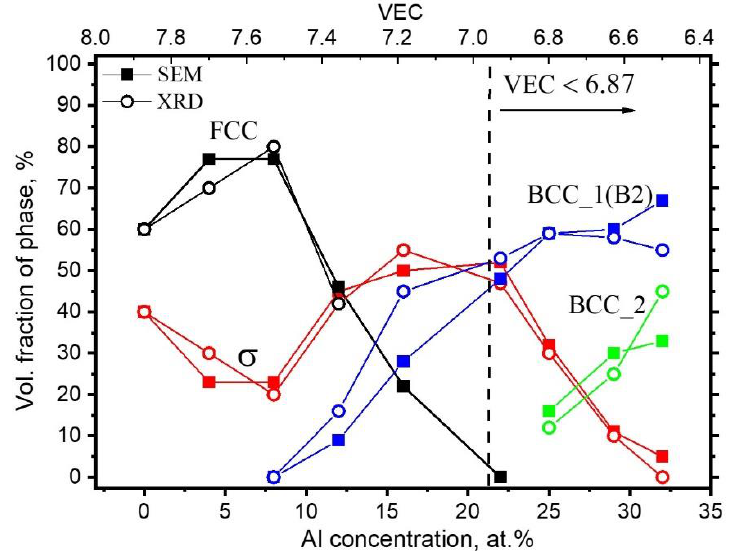
Figure 6. Volume fraction of phase in dependence of Al concentration determined by XRD (open circles) and SEM (squares).